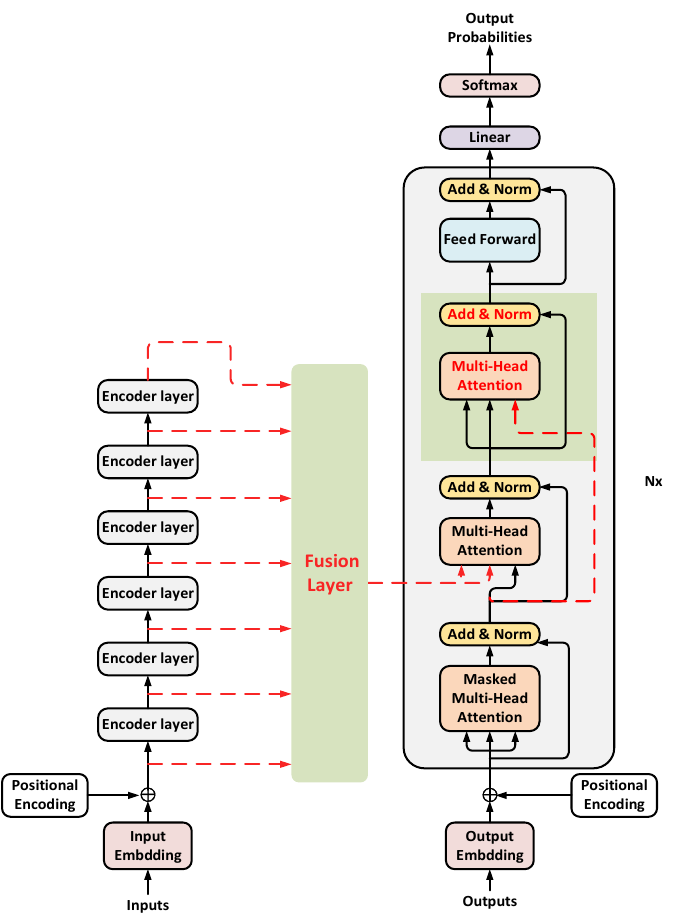
Figure 4. Multi-Attention Mechanism Translation Model Based on Vector Fusion. Figure 4. Multi‑Attention Mechanism Translation Model Based on Vector